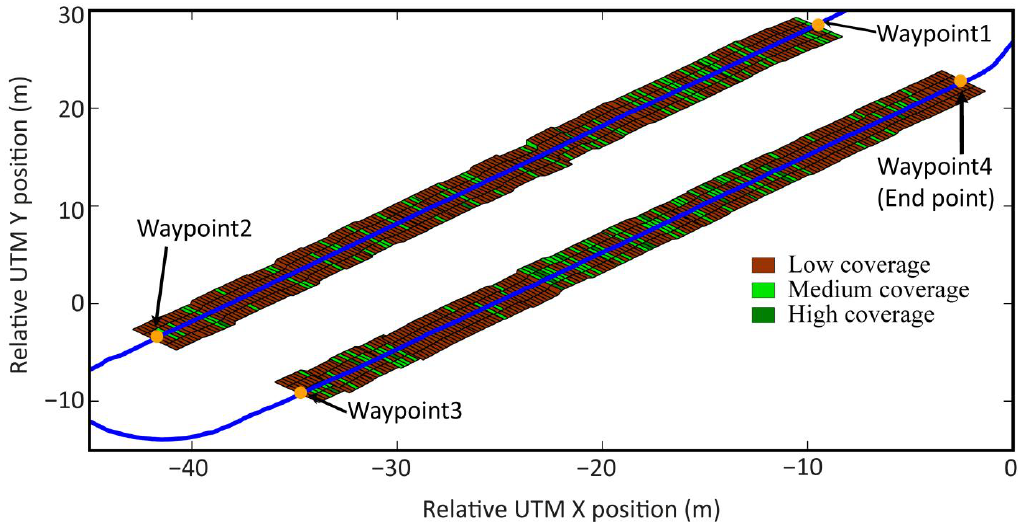
Figure 24. Resulting weed coverage map based on the weed density matrices and the interpretation of the three density levels.